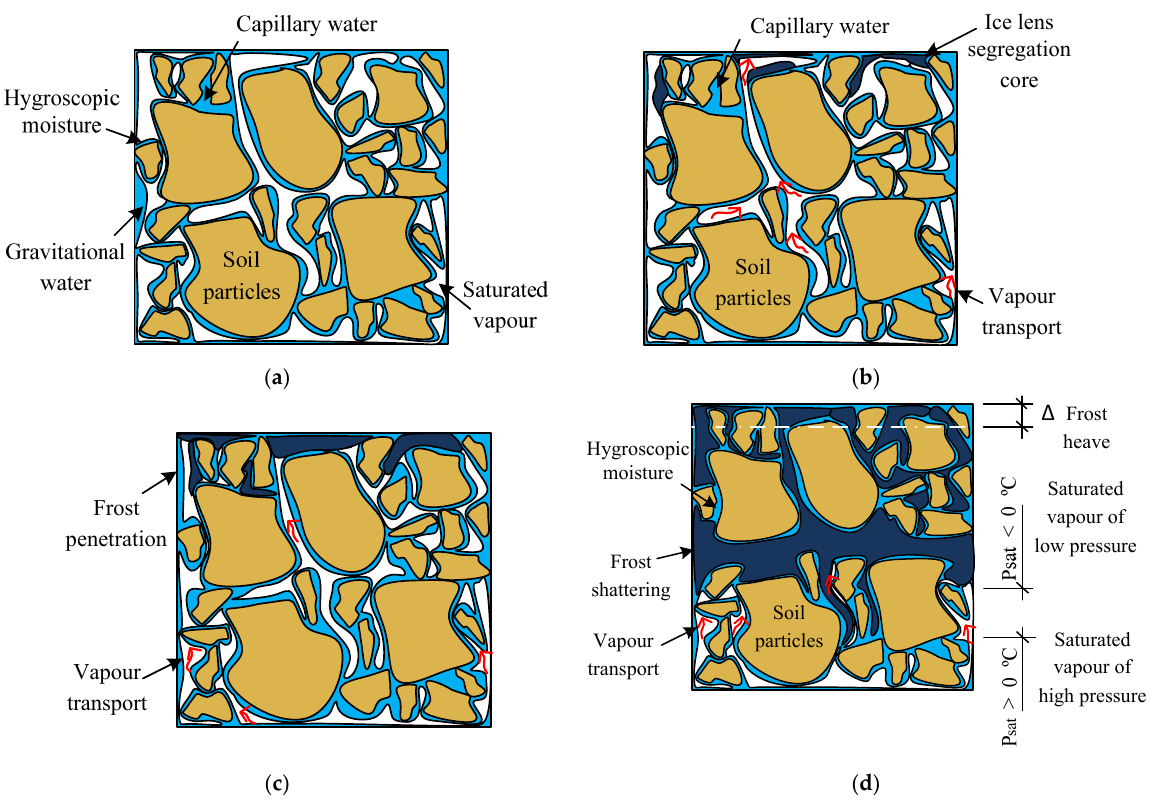
Figure 2. Soil sample structure at the different stages of freezing: ( a ) unfrozen equilibrium; ( b ) begin- ning of the freezing of ice lenses segregation; ( c ) further freezing or frost penetration; and ( d ) frost shattering and frost heave